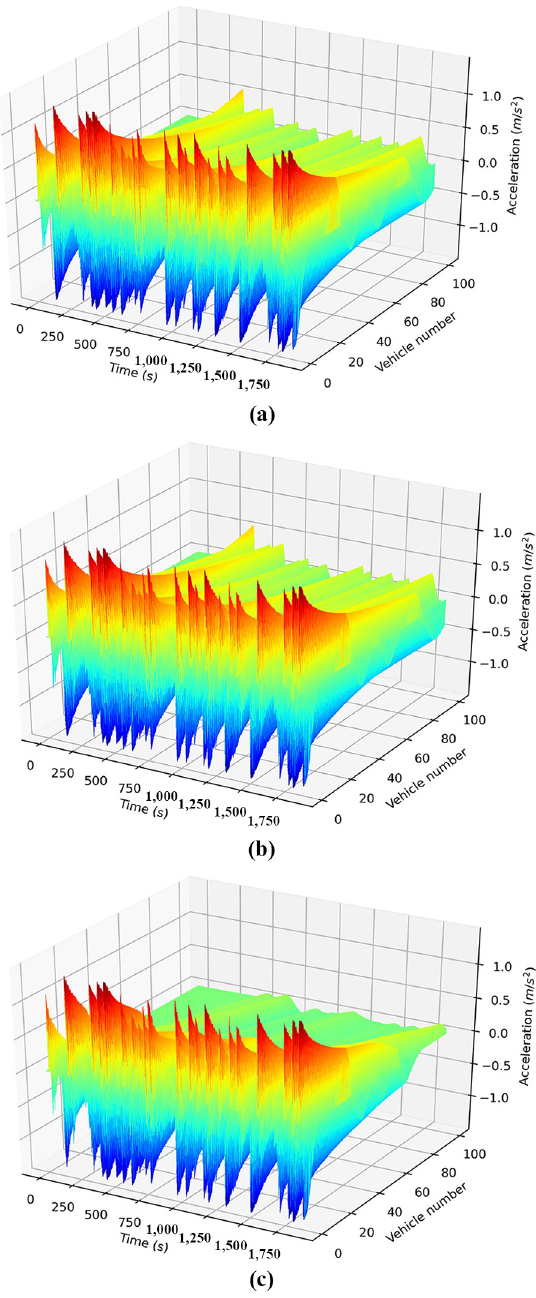
Figure 2 Acceleration pro fi les of vehicle platoon equipped with SDM, EcoSDM and SSDM